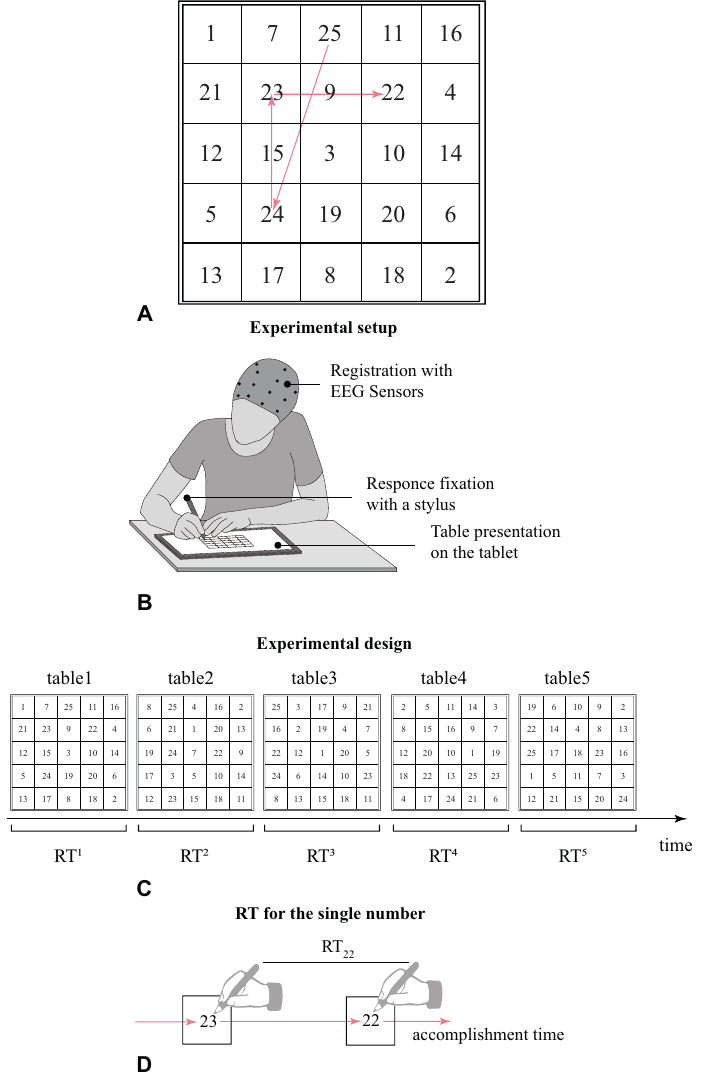
Figure 1. ( A ) An example of the Schulte table. The arrows show the accomplishment process. ( B ) Illustration of the experimental setup. The subject uses a stylus to accomplish the Schulte table on the tablet us screen. ( C ) Experimental design includes accomplishing the five different Schulte tables. ( D ) The schematical illustration of the response time taken to find the number “22” as the time spent between pointing number “22” and pointing the preceding number